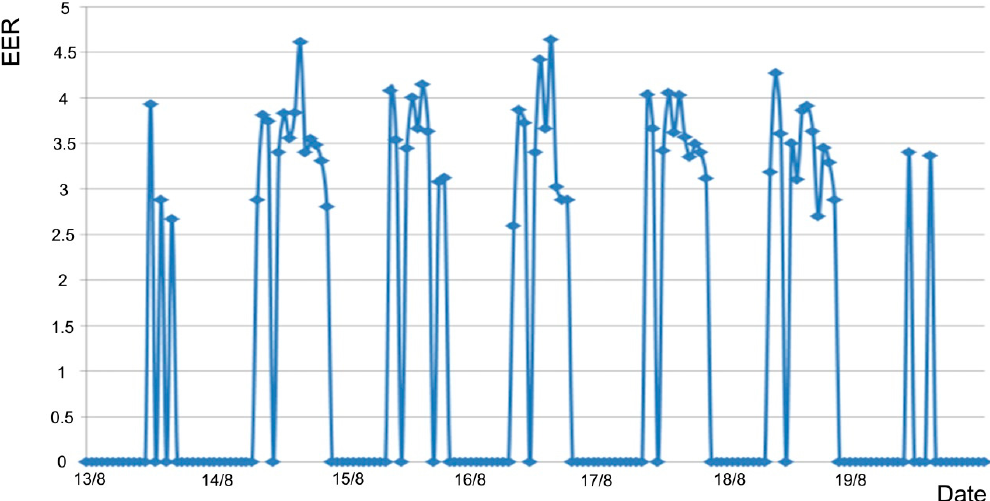
Figure 5. A 3 Resistance 1 Capacitance (3R1C) module.